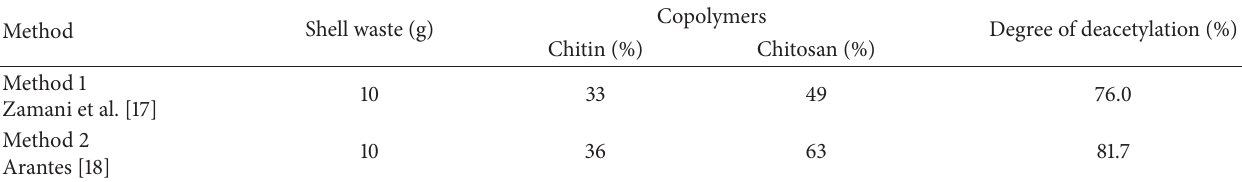
Table 1: Chitin and chitosan copolymers obtained by the proposed methodologies.